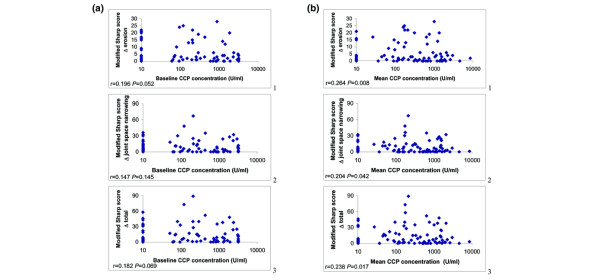
Correlation between (a) anti-cyclic citrullinated peptide (CCP) concentrations at baseline (month 0 (M0); panels 1 to 3) or (b) the mean serial anti-CCP concentrations (M0 + M12 + M36)/3; panels 1 to 3) and progression of the modified Sharp scores (Δ erosion, Δ joint space narrowing and Δ total score).